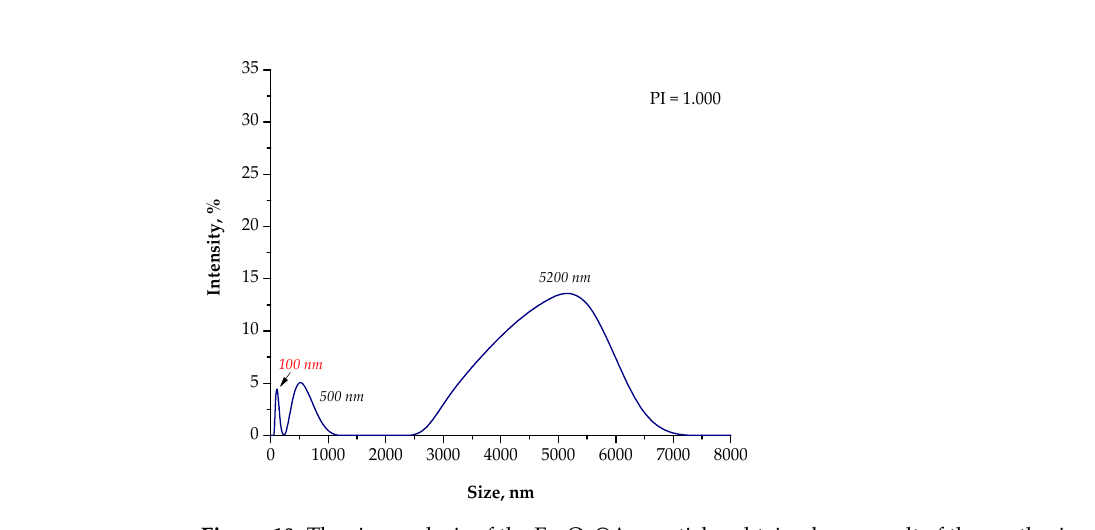
Figure 9. The size analysis of the Fe 3 O 4 @Ag particles obtained as a result of the synthesis performed using the 3% Arabic gum solution and the oil ( O ) reaction environment.